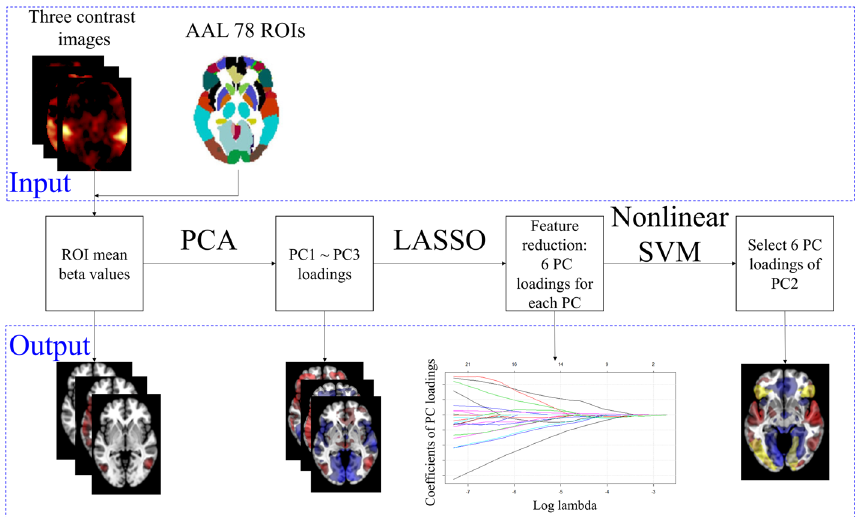
Figure 1. Analytical procedure of the machine learning approach based on multitask fMRI data. The proposed machine learning approach based on multitask fMRI data is shown. The upper box shows input data, and the lower box shows output data. Output data are displayed as voxel-based results to clarify the overall procedure.